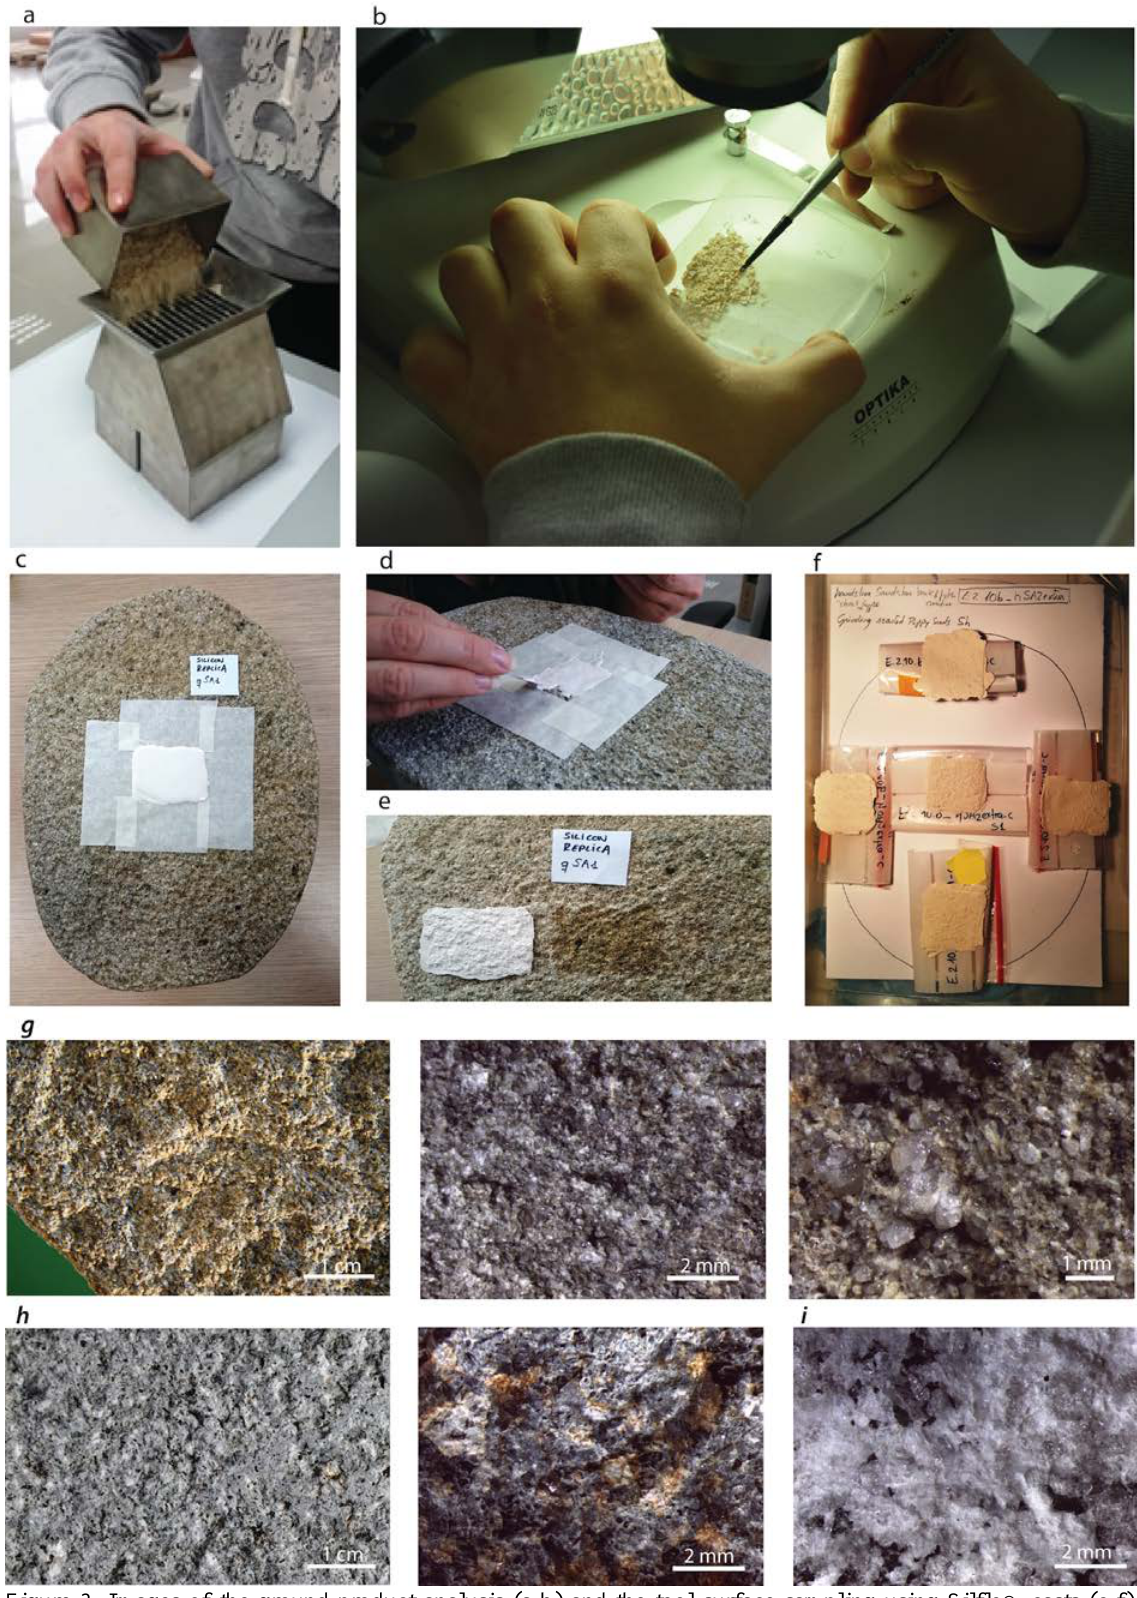
Figure 3. Images of the ground product analysis (a-b) and the tool surface sampling using Silflo® casts (c-f). Pecked surfaces after the manufacture: sandstone (g), andesite (h) and granite